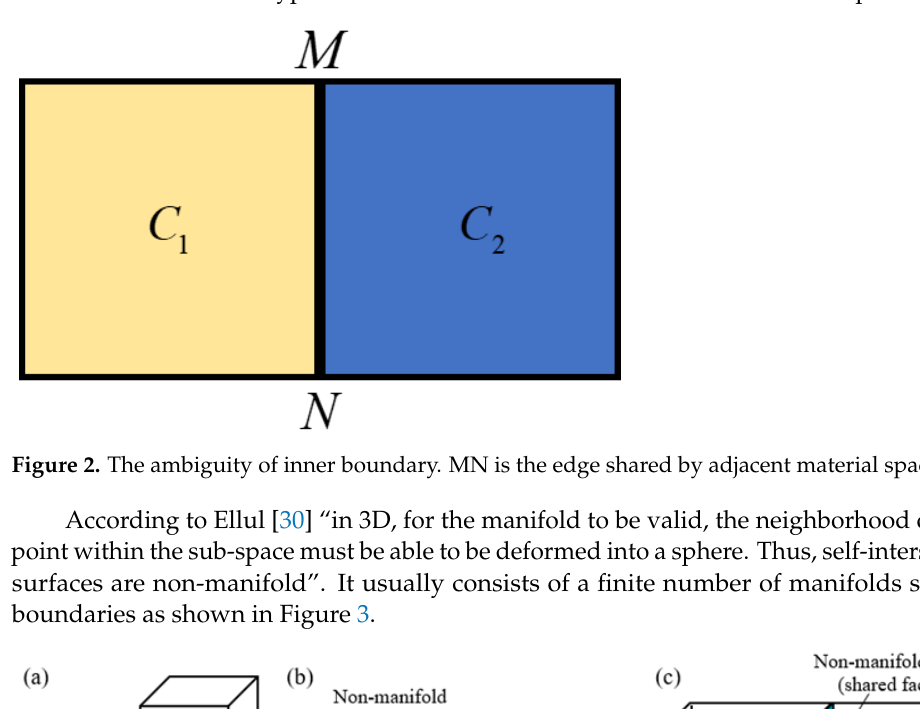
Figure 3. A non-manifold object formed by sharing ( a ) a vertex; ( b ) an edge; ( c ) a face.